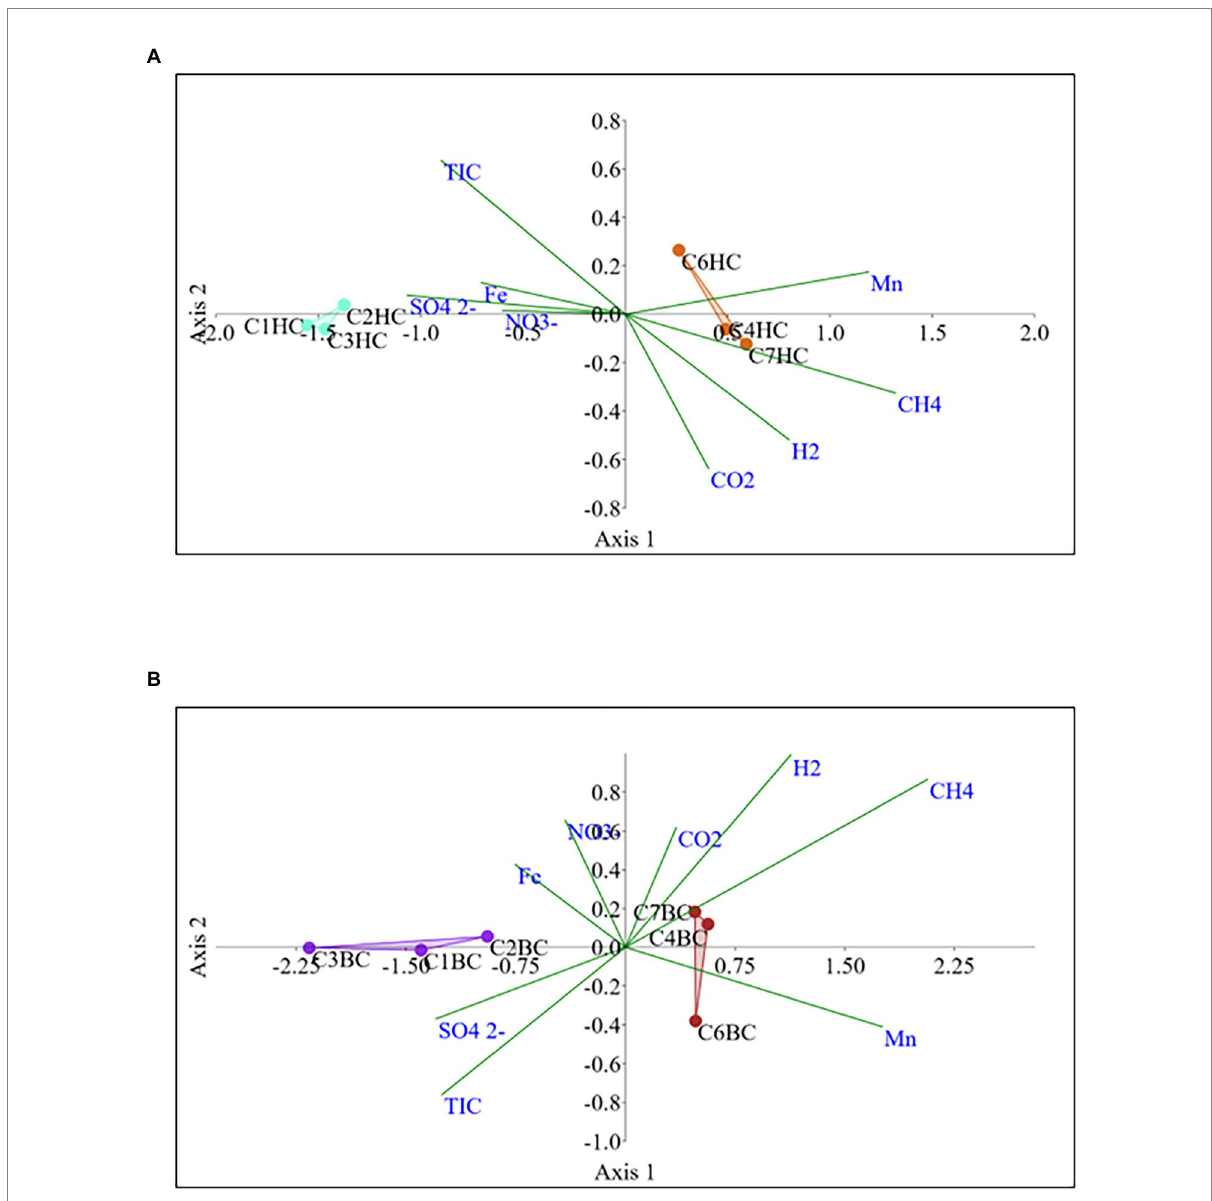
FIGURE 6 Canonical correspondence analysis for microbial taxa belonging (A) HC and (B) BC enrichment based on their association with depth and relevant geochemical